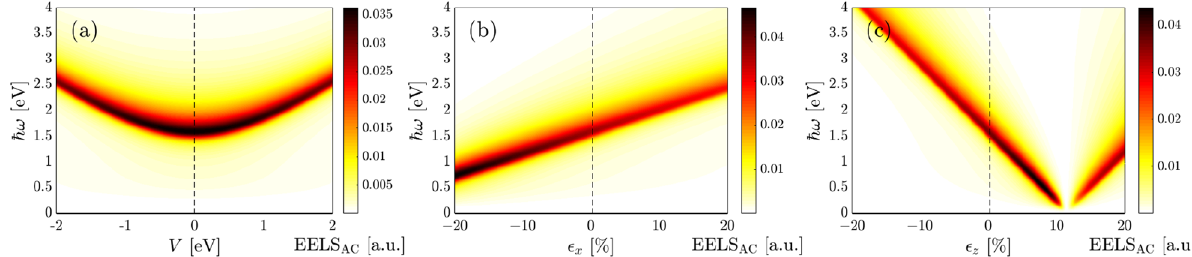
Figure 5. EELS (in arbitrary units) of monolayer perturbed BP along the AC direction as functions of the incident optical energy (cid:31) ω , ( a ) gate voltage V in the absence of strain ǫ x 0 and ( c ) strain ǫ ǫ z eV and ǫ y = =